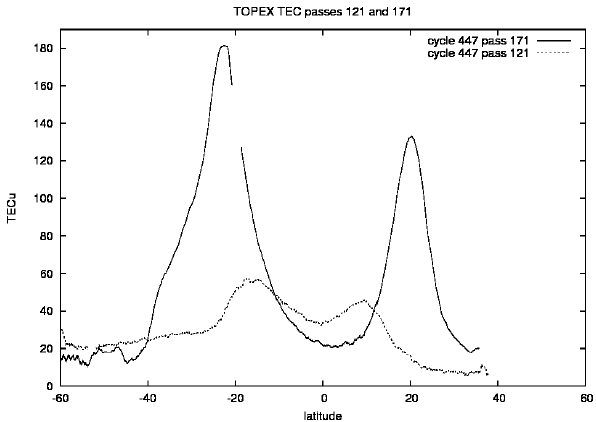
Figure 3 (b) Passes 121 (cycle 447 – 06/11/2004) and 171 (cycle 447 – 08/11/2004) of TOPEX as a function of geographic latitude.